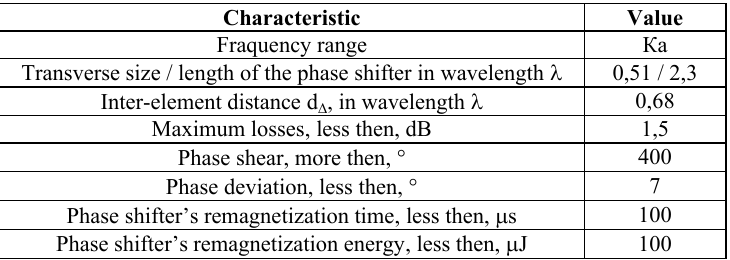
Table 1. Characteristics of PAA